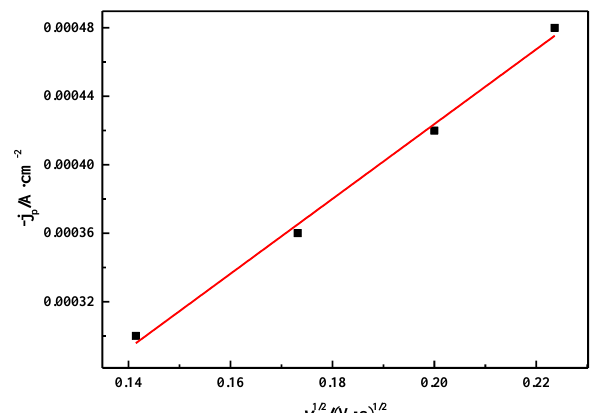
Figure 9. Cyclic voltammetry curves of ChCl-MA-BiCl 3 at different scan rates (T = 343 K, c(BiCl 3 )) = 0.10 M).